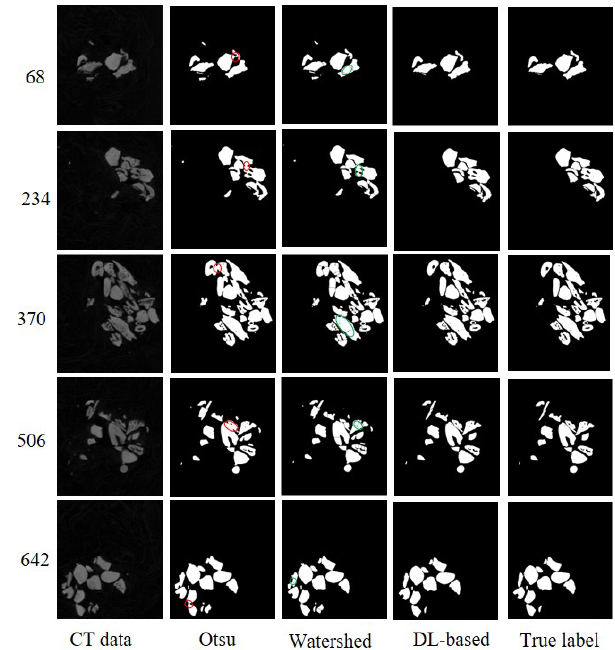
Figure 7. Comparison between popular methods and the DL-based method.